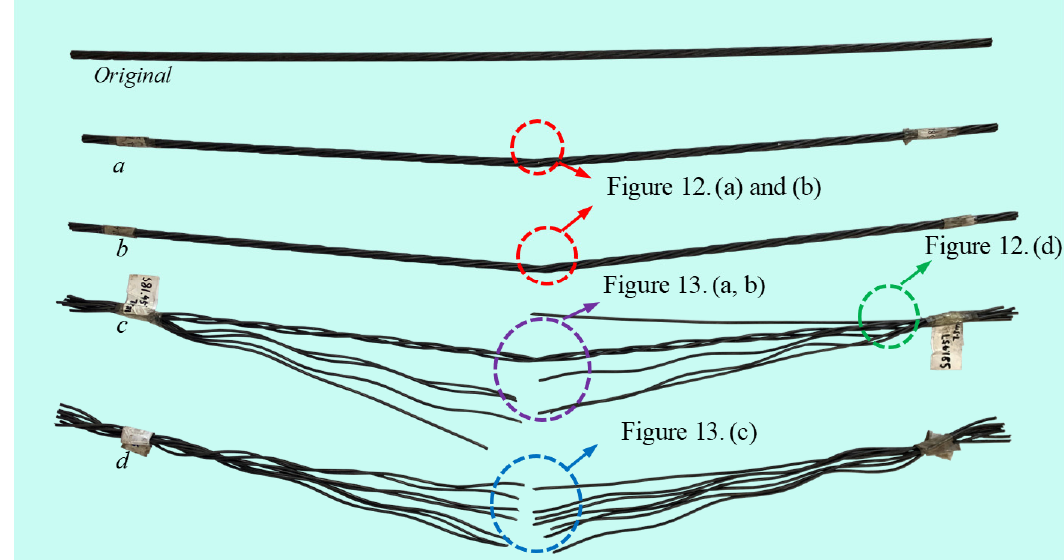
Figure 11. Deformed profiles and failure modes of strand cables under concentrated impact: ( a ) µ p = 0.0, V 0 = 6.85 m/s; ( b ) µ p = 0.103, V 0 = 11.23 m/s; ( c ) µ p = 0.196, V 0 = 12.64 m/s; ( d ) µ p = 0.396, V 0 = 12.72 m/s.